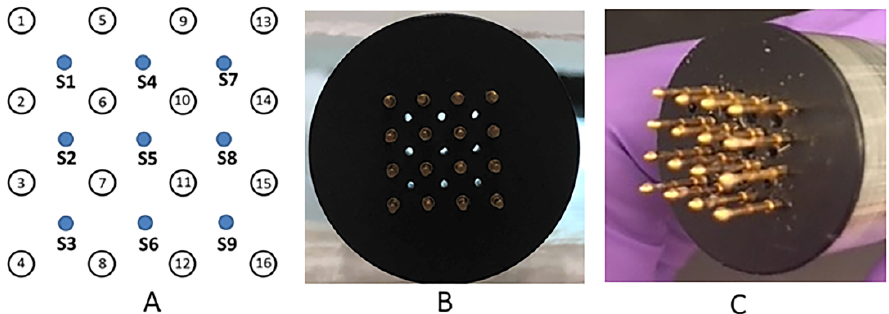
Figure 1. Moderate heat-assisted GET device. ( A ) The 16 pin MEA with evenly interspersed nine optical fibers encased within a Teflon cap. Each of the 16 pins is represented by circles with numbers. Holes between each cluster of 4 pins is where the fiber optic outputs are located (represented by blue circles labeled S1–S9). ( B ) Moderate heating is accommodated by an infrared laser split into nine equally spaced fibers (visible as holes). ( C ) Array from side angle showing clear view of the spring-loaded pins. GET pulses are applied from these spring-loaded pins that are placed in contact with skin target.